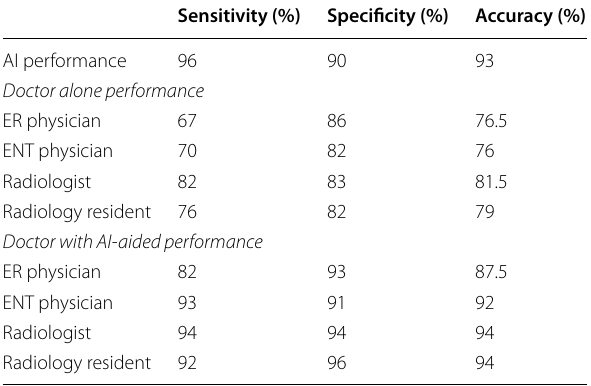
Table 2 Performances on the testing set of the AI model and doctors with and without AI assistance